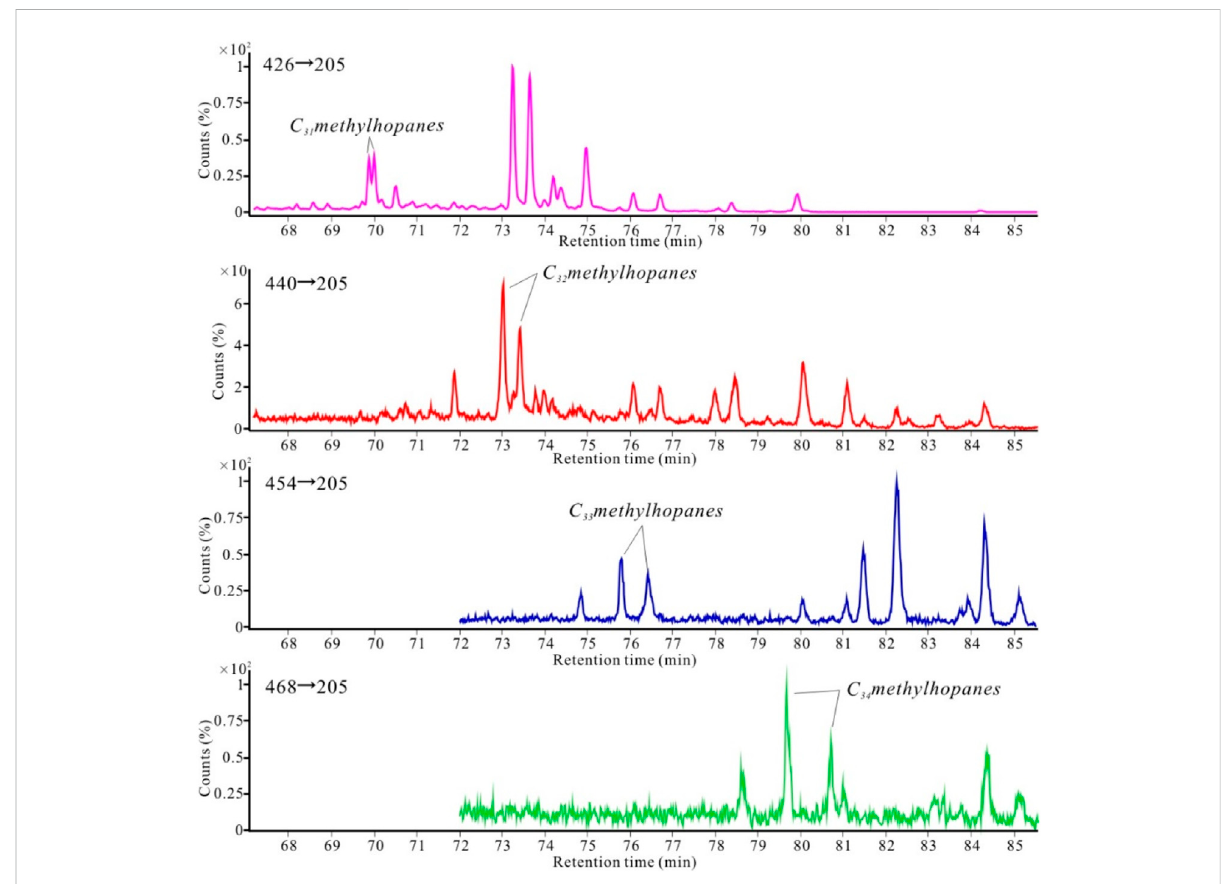
FIGURE 11 Gas chromatography-tandem mass spectrometry chromatograms of the methylhopane series in the body of concretion A.